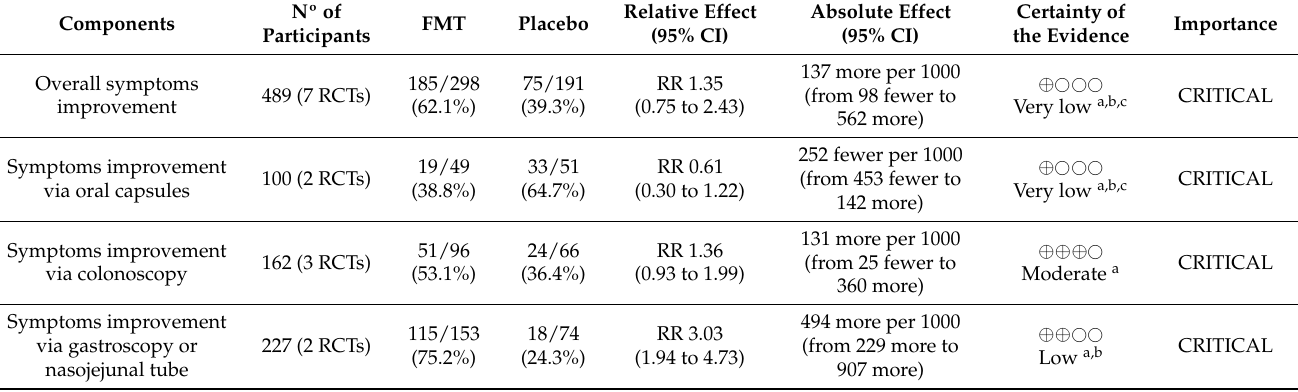
Table 3. GRADE summary of evidence on the efficacy of FMT in IBS by administration